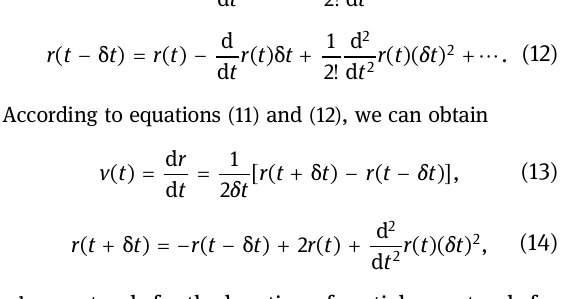
table fl uctuation for attributes that depend on long - term